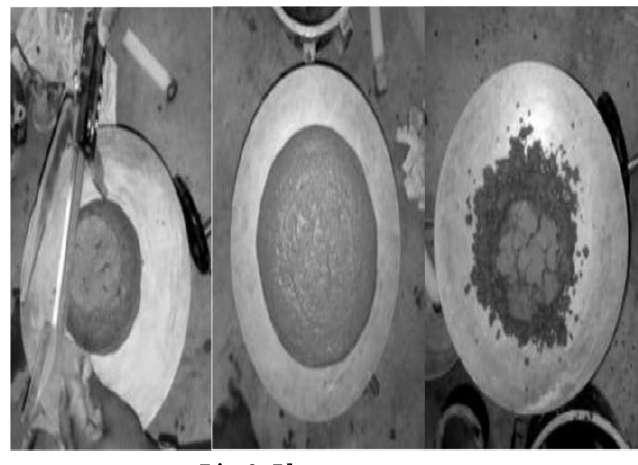
Fig. 9. Flow mortar test